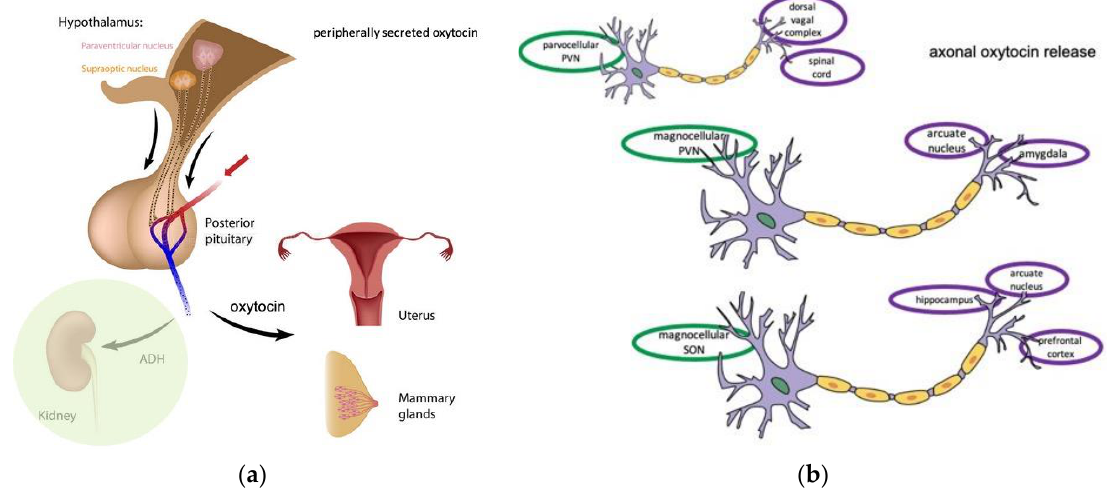
Figure 1. Diagram showing the peripherally secreted oxytocin ( a ) and the axonal oxytocin release ( b